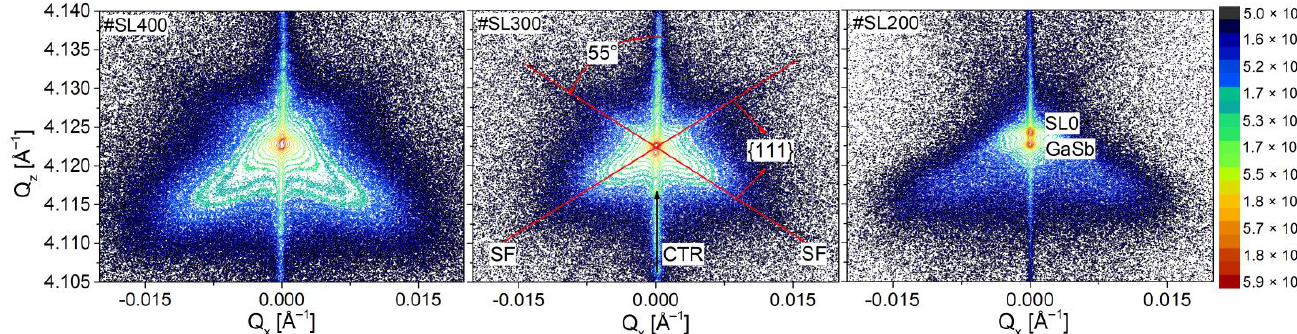
Figure 2. Distribution of diffuse scattering in reciprocal space maps measured along [110] direction for 004 reflection for #SL400 (400 periods), #SL300 (300 periods) and #SL200 (200 periods).